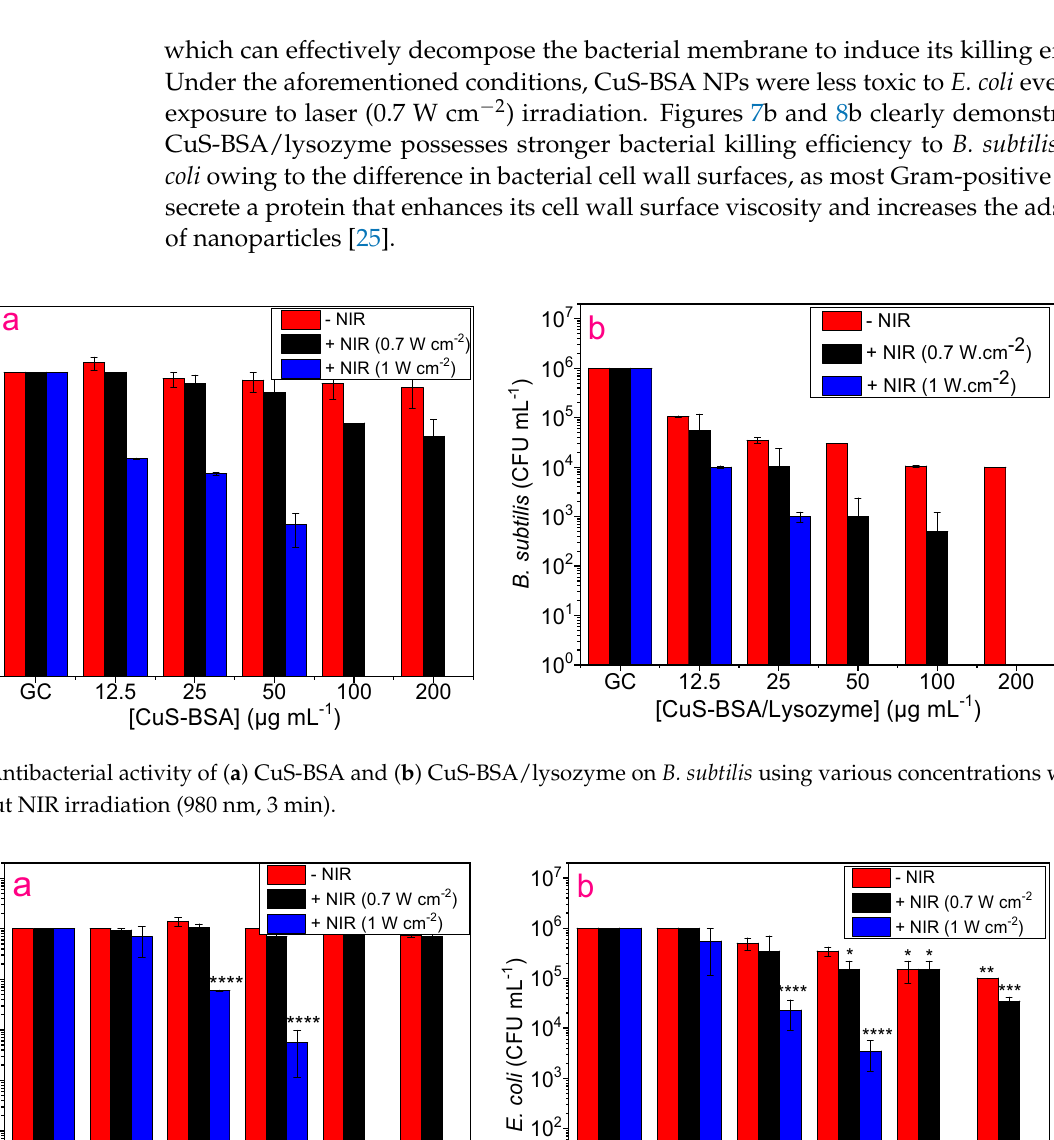
Figure 8. Antibacterial activity of ( a ) CuS-BSA and ( b ) CuS-BSA/lysozyme on E. coli using various concentrations with and without NIR irradiation (980 nm, 3 min). * p < 0.05, ** p < 0.01, *** p < 0.001, **** p < 0.0001.